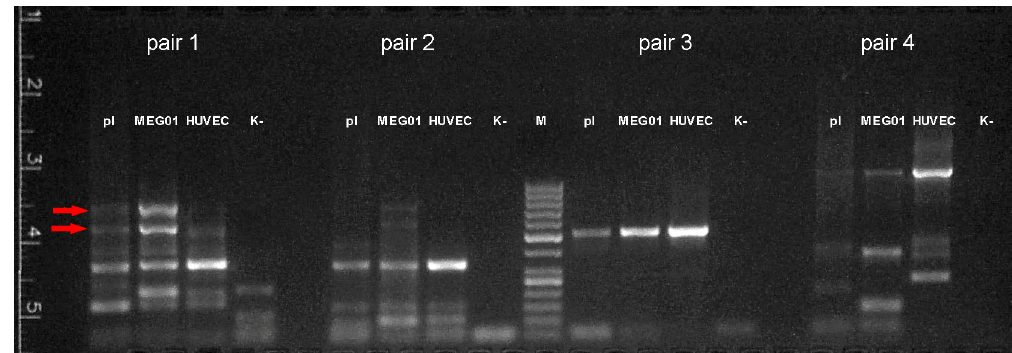
Figure 6. Results of reverse transcription PCR with RNA isolated from platelets (pl), MEG01, and HUVEC cells. M—size